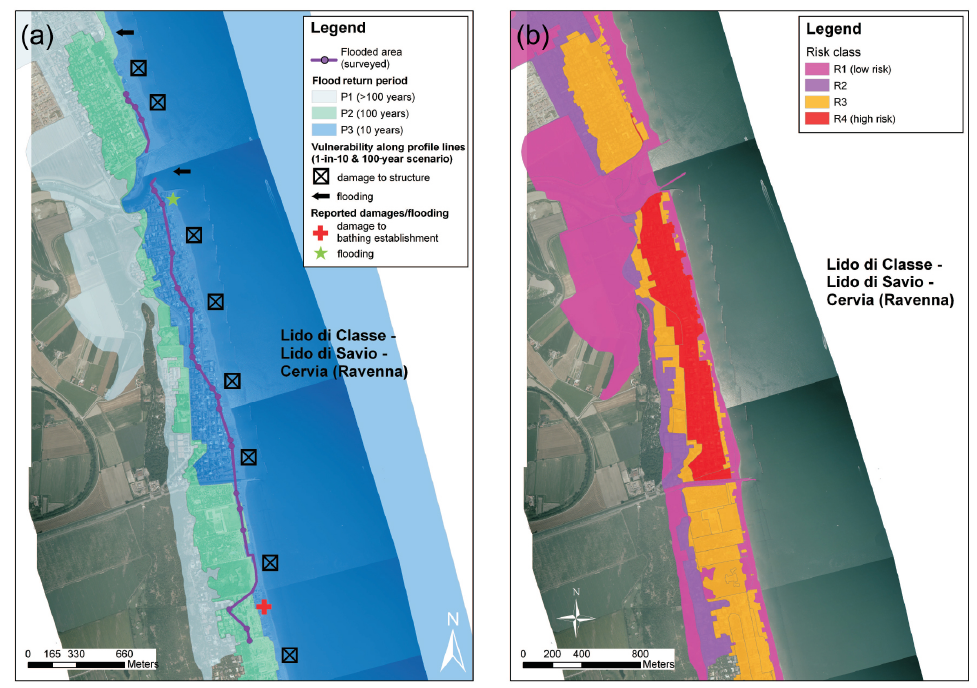
Figure 6. The Lido di Classe–Lido di Savio–Cervia sites. (a) Hazard map with post-storm survey, reported impacts and legend along profile lines of the 10- and 100-year return period scenarios. (b) Risk